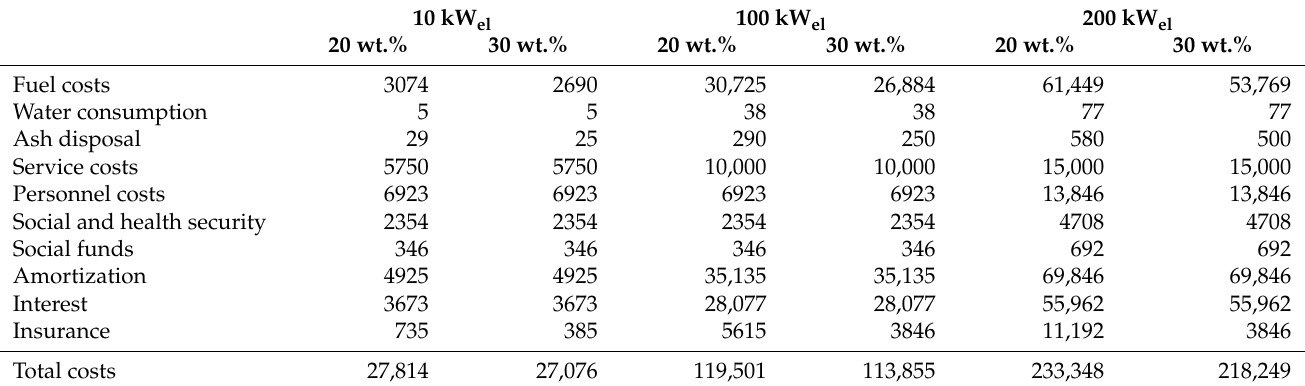
Table 6. Operating costs of individual variants of electric output and wood chip moisture in EUR. 10 kW el 100 kW el 200 kW el 20 wt.% 30